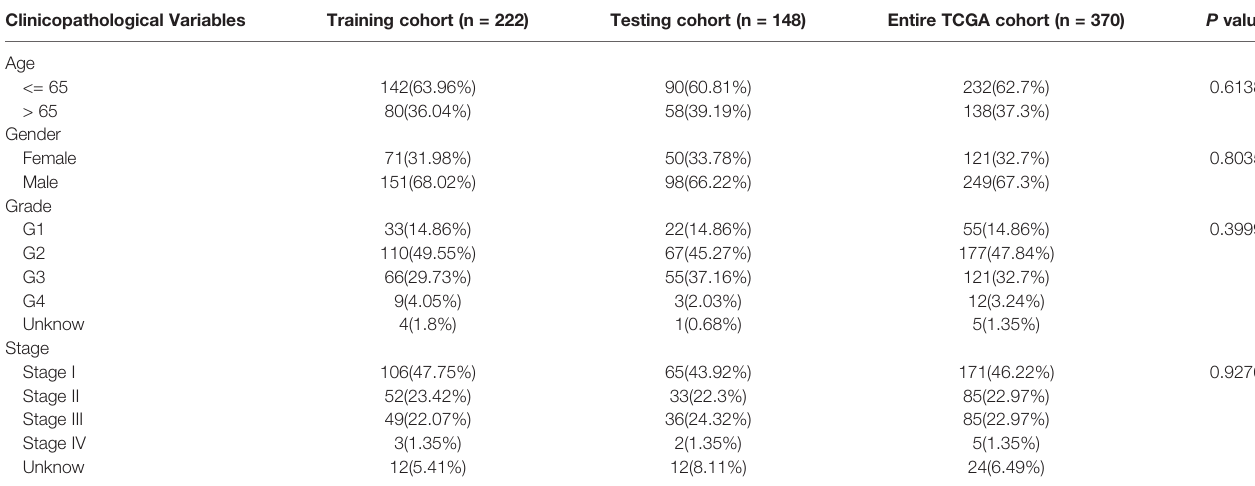
TABLE 1 | Clinicopathological characteristics of the HCC patient in each cohort. Clinicopathological